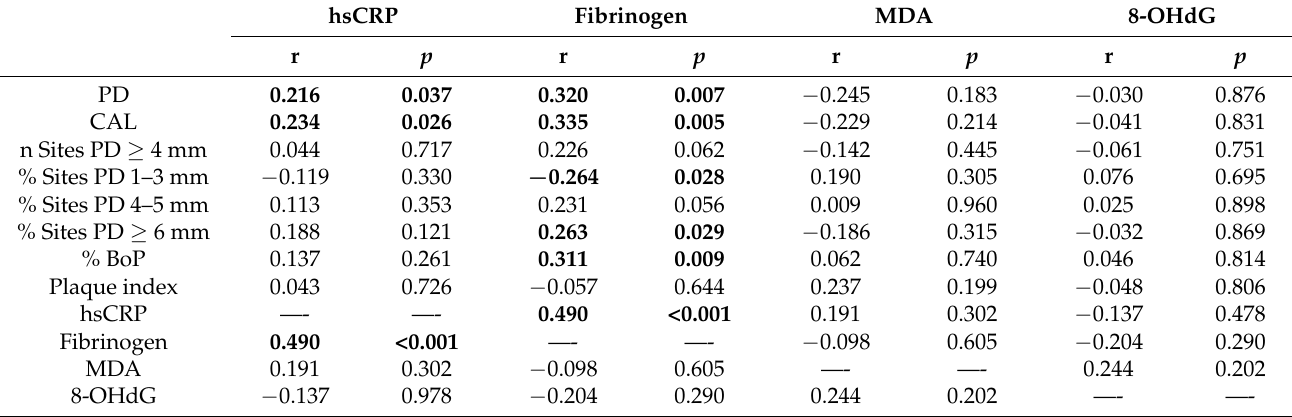
Table 2. Spearman’s correlation coefficients between periodontal, inflammatory, and oxidative stress